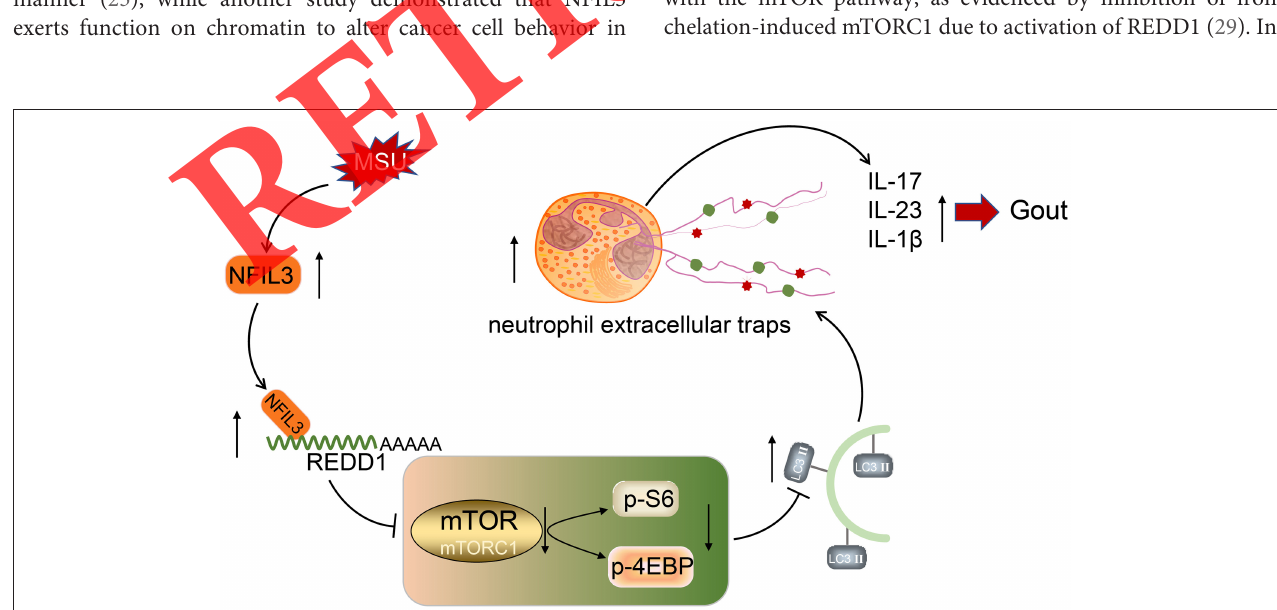
Frontiers in Medicine |